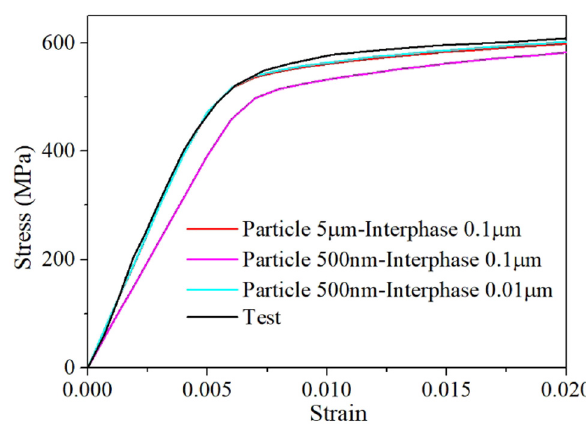
Figure 13: The stress – strain curves predicted by the RVE with dif - ferent DTM particle sizes and interphase thickness.